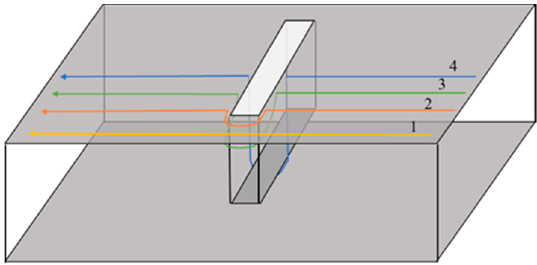
Figure 2. Current path classification on the ground plane.